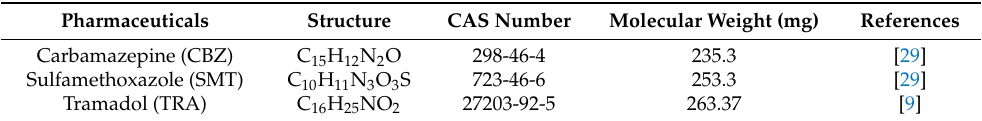
Table 1. Characteristics of the pharmaceuticals.